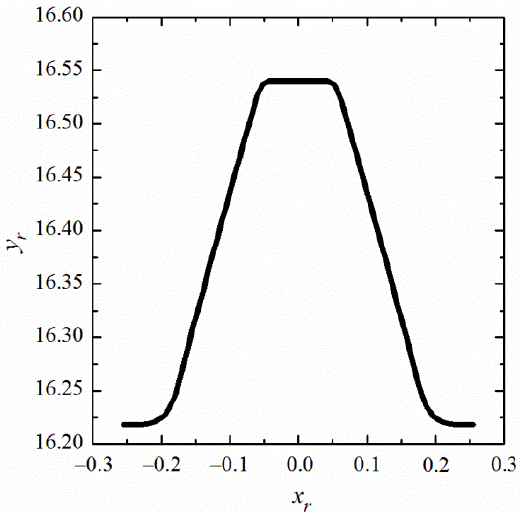
Figure 5. Tooth profile of the disposable flexible wheel.